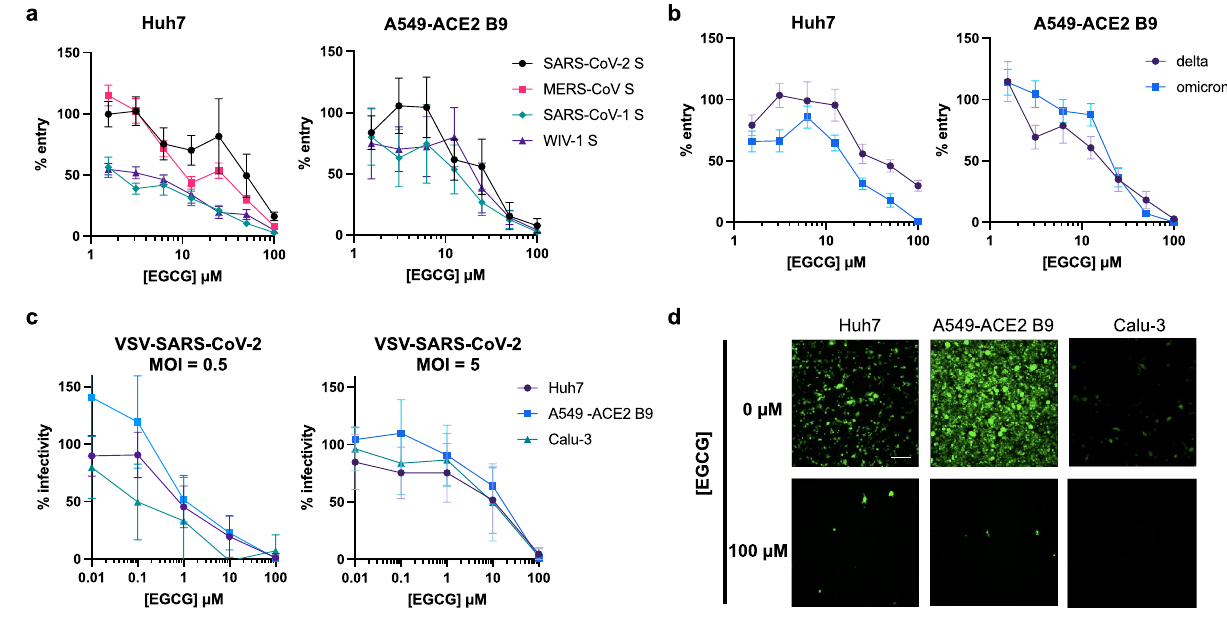
Figure 2. EGCG inhibits entry mediated by spike of highly pathogenic CoVs and a pre-emergent bat CoV. ( a- b ) EGCG pre-treatment reduced entry of SARS-CoV-1, MERS-CoV, SARS-CoV-2 (ancestral, delta or omicron), or WIV1-CoV pseudoparticles into Huh7 or A549-ACE2 cells. Mean values with standard error of the mean from three independent experiments each done in triplicate are plotted. ( c ) EGCG inhibits VSV-SARS-CoV-2 infection in Huh7, A549-ACE2 B9 and Calu-3 cells. Its antiviral potency is dependent on the multiplicity of infection (MOI). Mean values with standard deviation of three independent experiments each in duplicate are plotted. ( d ) Representative images are shown. Scale bar: 200